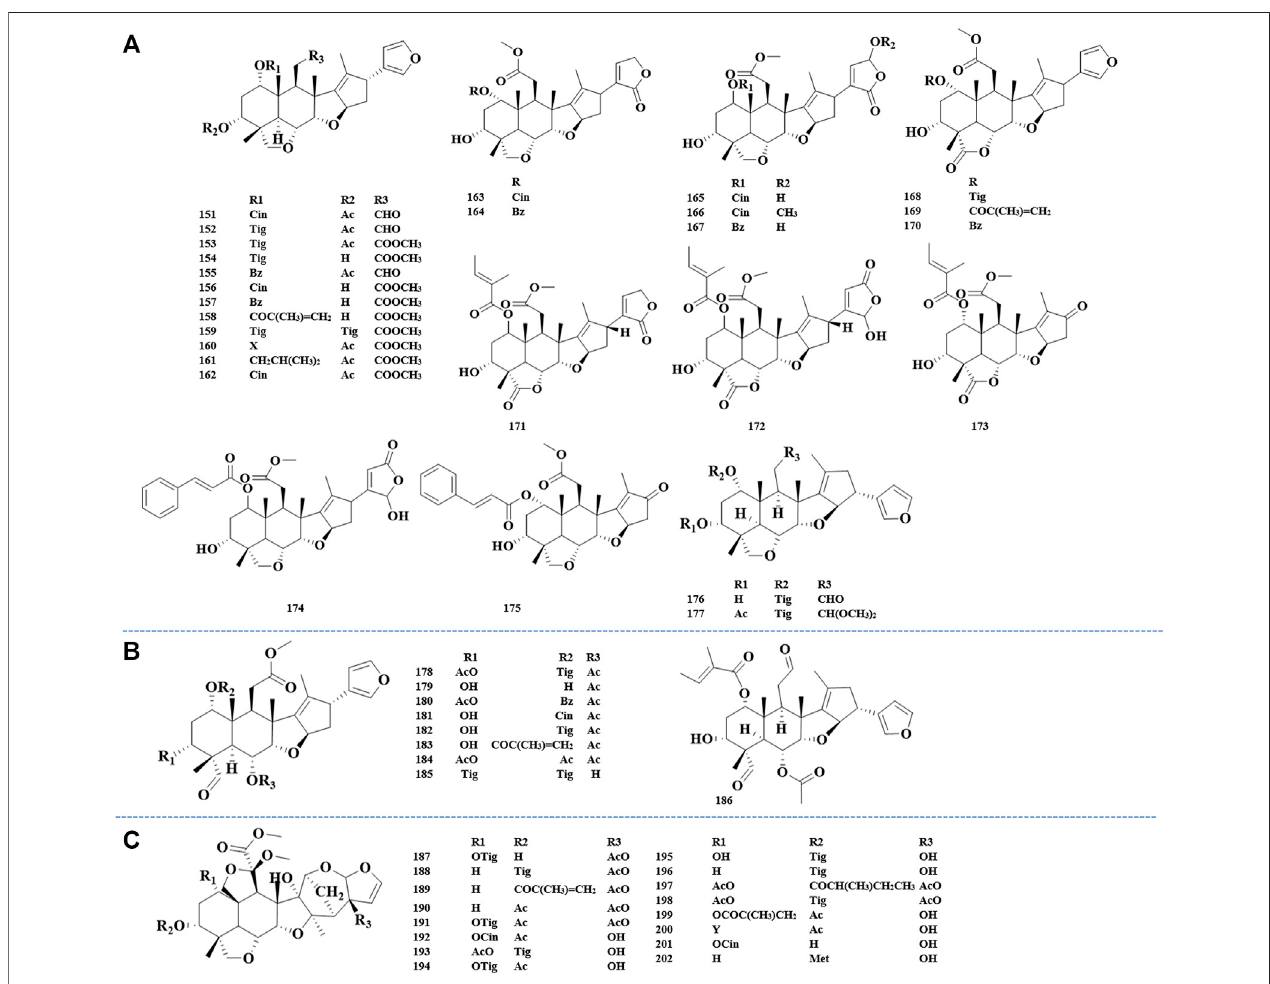
FIGURE 5 | Structures of salannin class limonoids 151 – 177 (A) , structures of ohchinolal class limonoids 178 – 186 (B) , and structures of meliacarpinin class limonoids 187 – 202 (C) .